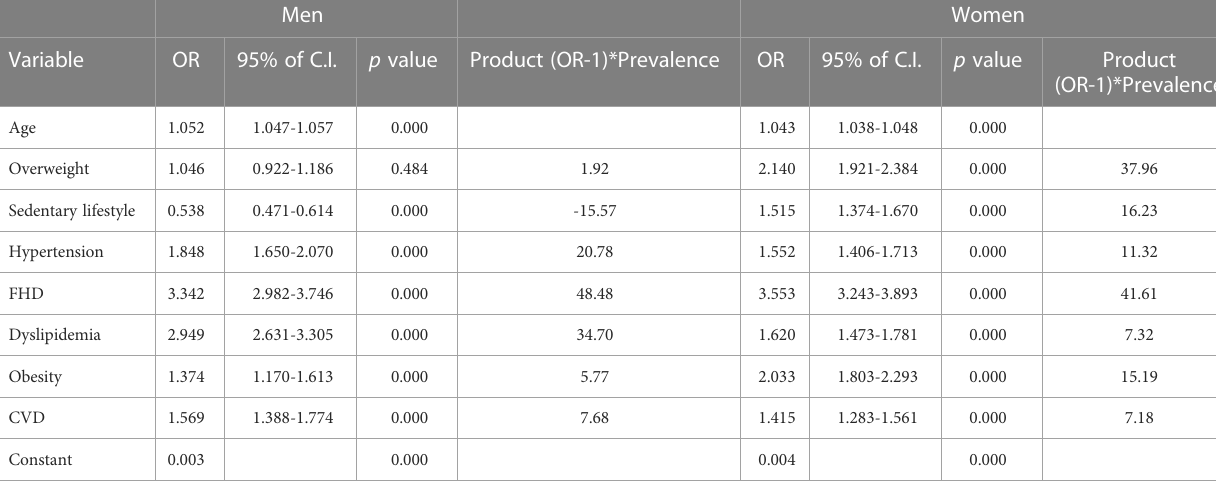
TABLE 3 Binary logistic regression analysis of risk factors for impaired glucose regulation among men and women. Men Women